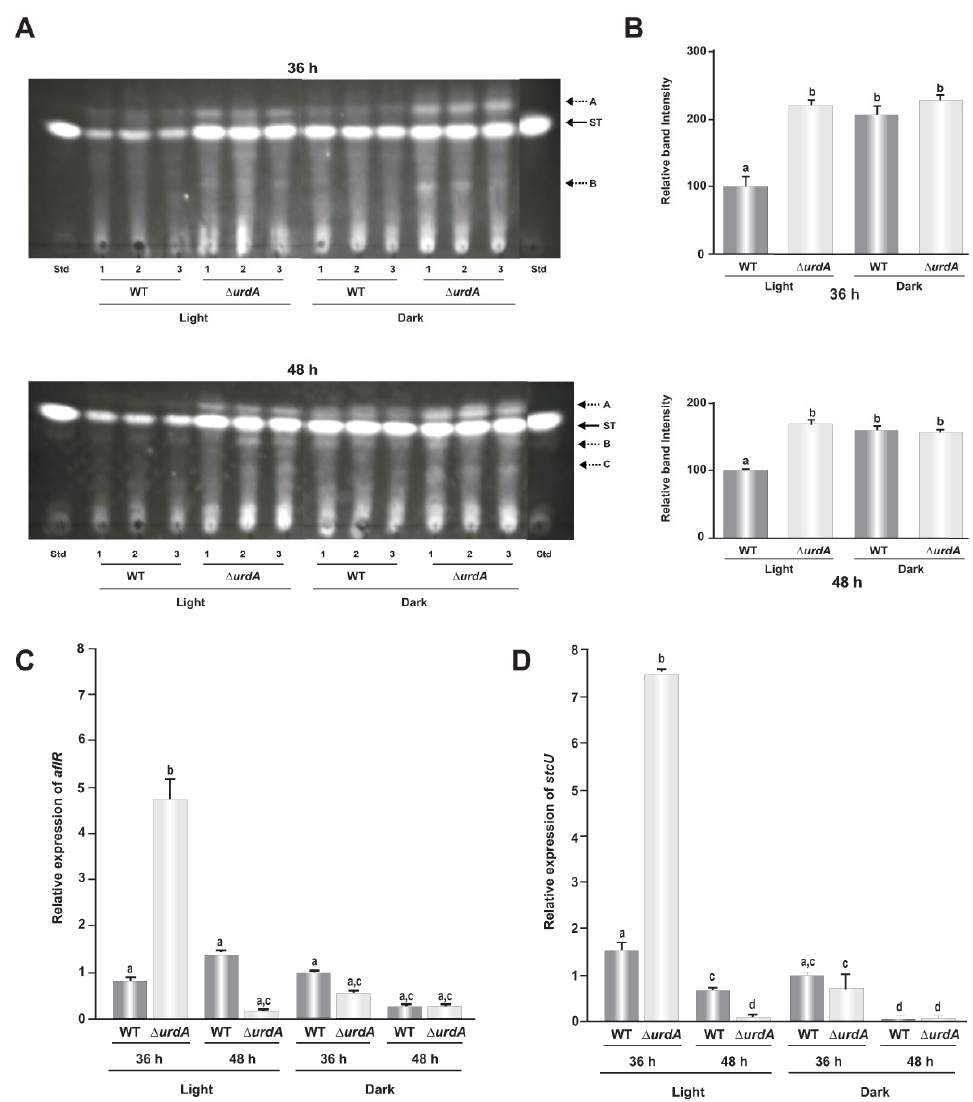
Figure 7. Effect of urdA on sterigmatocystin (ST) production in A. nidulans. ( A ) Thin‐layer chromatography (TLC) analysis of ST produced by wild type (WT) and Δ urdA cultures grown on top‐agar inoculated solid GMM at 37 °C in light and dark conditions for 36 h, and 48 h. ST, a commercial ST standard from SIGMA. Broken arrows indicate other metabolites whose synthesis is also affected by urdA . ( B ) Densitometry of the ST bands using ImageJ software [51] . The ST bands were normalized to wild‐type levels in the light, considered as 100 percent. ( C ) Effect of urdA on aflR and stcU expression analyzed by RT‐qPCR. Values are means of three replicates and error bar indicates standard errors. Different letters above the bar graphs represent significantly different values ( p ≤ 0.05).